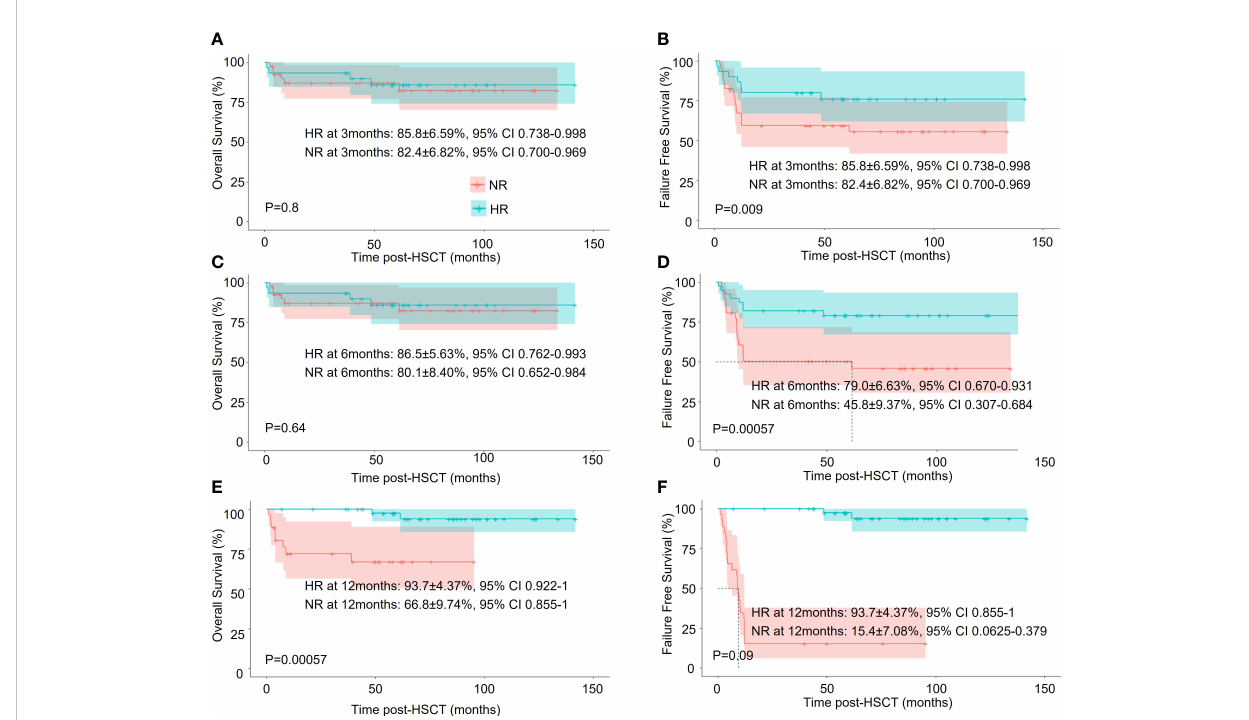
FIGURE 3 Survival analysis of HAAA patients in the IST group with different treatment responses. (A, C, E) Overall survival (OS); (B, D, F) Failure-free-survival (FFS).